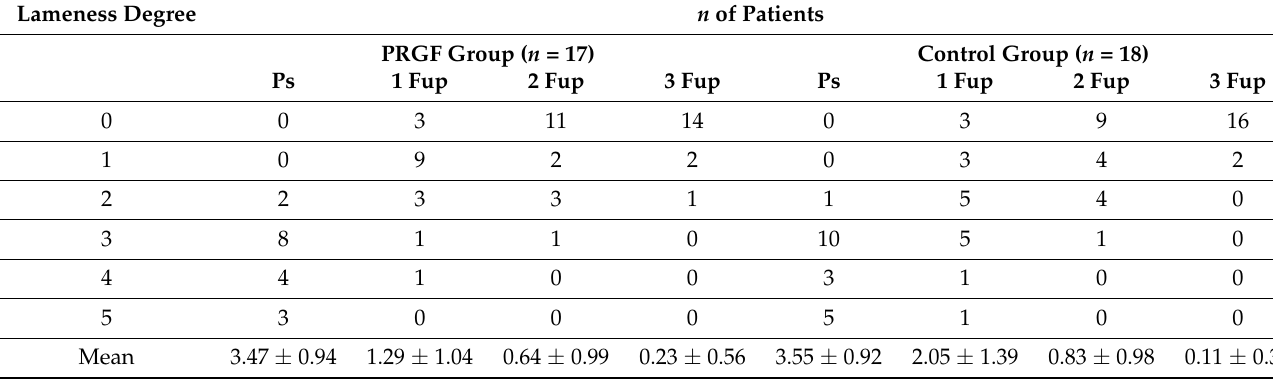
Table 4. n of patients by lameness